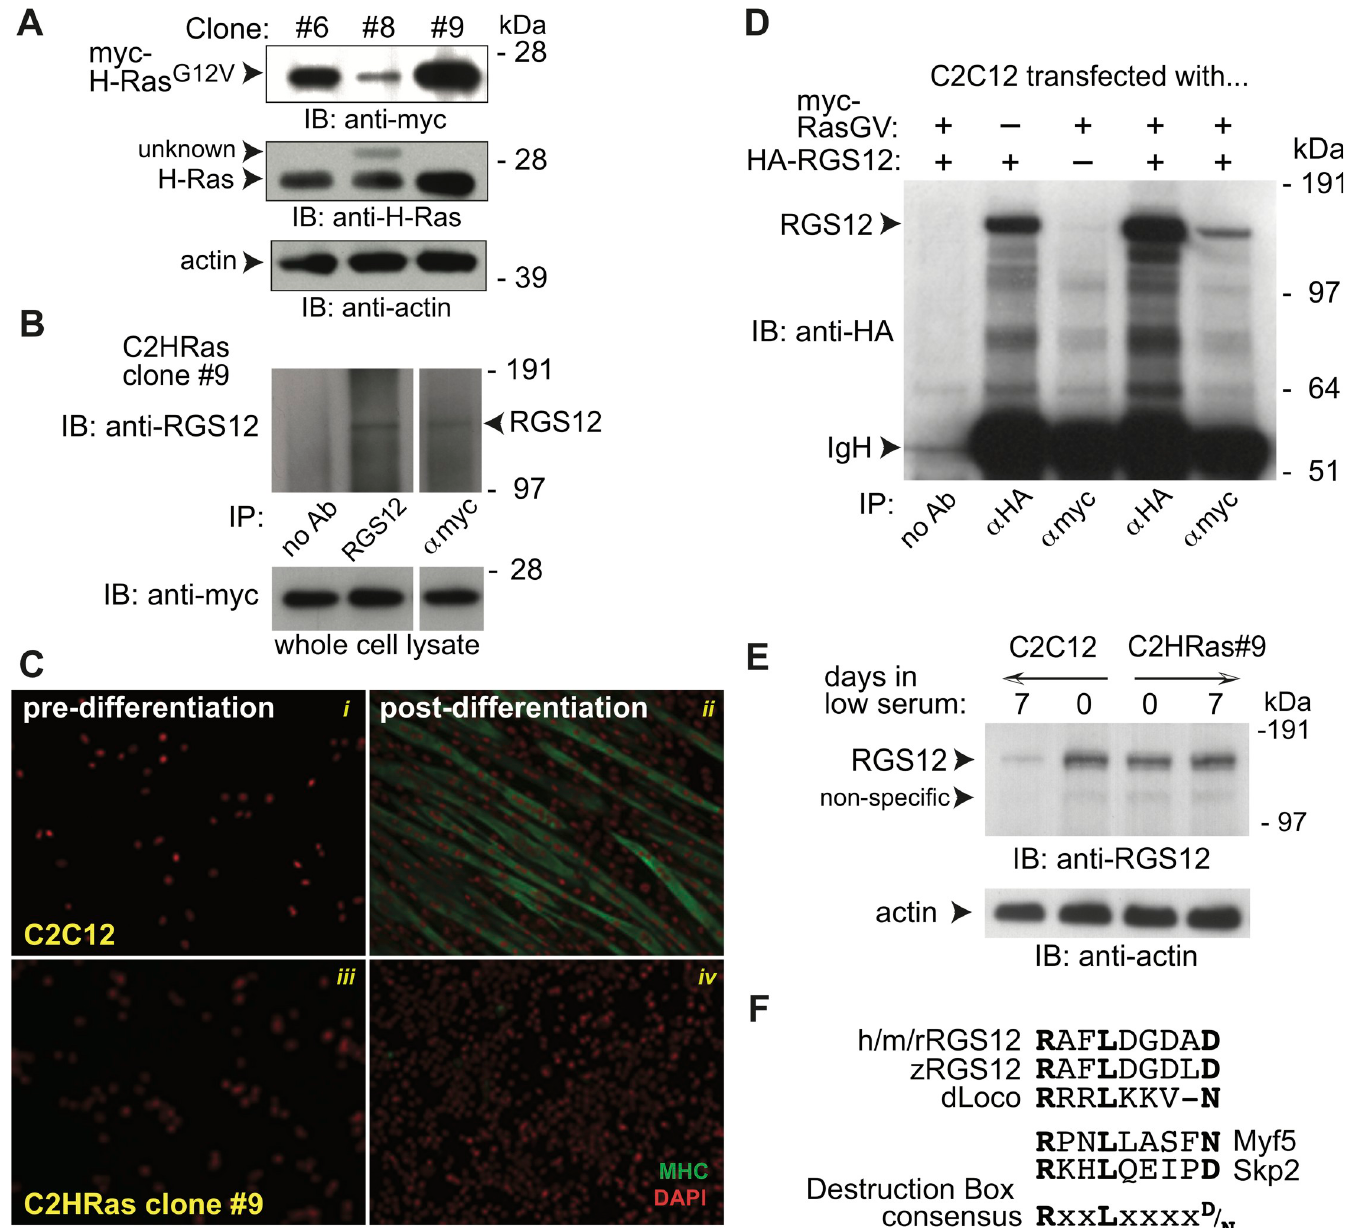
Fig 3. RGS12 interacts with activated H-Ras and is downregulated within the C2C12 cell line during differentiation. (A) Immunoblotting (IB) of cell lysates from three stable clones of the C2C12 cell line indicating their stable expression of a constitutively-active, GTPase-deficient (G12V) mutant of H-Ras protein (via detection of its N-terminal myc-epitope tag). (B) Co-immunoprecipitation of myc-tagged, activated H-Ras (G12V mutant) with endogenous RGS12 protein expressed in the C2HRas cell line clone 9. IP: immunoprecipitation; IB: immunoblotting. (C) To test the effect of stable expression of activated H-Ras on myoblast differentiation in vitro , multi-nucleated myotube content of indicated cell populations (either parental C2C12 cells [panels i, ii] or C2HRas clone #9 cells [panels iii, iv]) was measured by fixation and staining for sarcomere myosin (MHC; green ) and nuclear DNA content (DAPI; pseudocolored red ), either pre-differentiation (panels i, iii) or post- differentiation by culture for 5 days in low serum (2% horse serum; panels ii, iv). The mean fusion index for several C2C12 cell populations was 40% ( ± 2.5%; SEM), consistent with other reports [68, 69]. In contrast, the C2HRas cell line clone 9 was incapable of myotube formation (panel iv) and no fusion index could be calculated. (D) Co-immunoprecipitation of myc-tagged, activated H-Ras (G12V mutant) with ectopically co-expressed, HA-tagged RGS12 in C2C12 cells. IgH: immunoglobulin heavy-chain. (E) Endogenous levels of RGS12 protein are down-regulated during C2C12 differentiation into myotubes ( i . e ., 7 days of culture in low serum medium), whereas the same culture conditions did not lower RGS12 levels within the C2HRas cell line clone #9. (F) Mammalian RGS12 proteins encode a “destruction box” recognition motif, conforming to the consensus RxxLxxxx(D/N), where “x” is any amino-acid, that is found in most substrates of the Anaphase-Promoting Complex (APC). This destruction box sequence is completely conserved across human (h), mouse (m), and rat (r) RGS12 proteins (i.e., amino acids 402–410 of mouse RGS12: RAFLDGDAD); this consensus motif is preserved in zebrafish (z) and Drosophila (d) RGS12 orthologs, as well as in the APC targets Skp2 and Myf5.